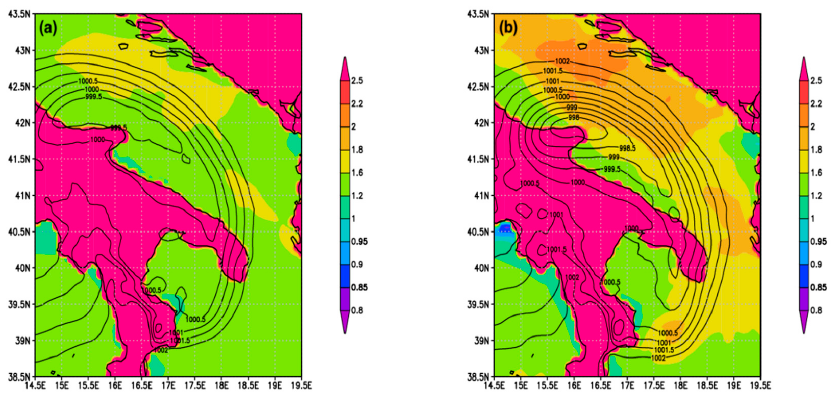
Figure 8. Averaged (0500–2000) UTC 26 September 2006 drag coefficient (shaded line) and sea-level pressure (isolines) for CPL0 run ( a ); and CPL5 run ( b